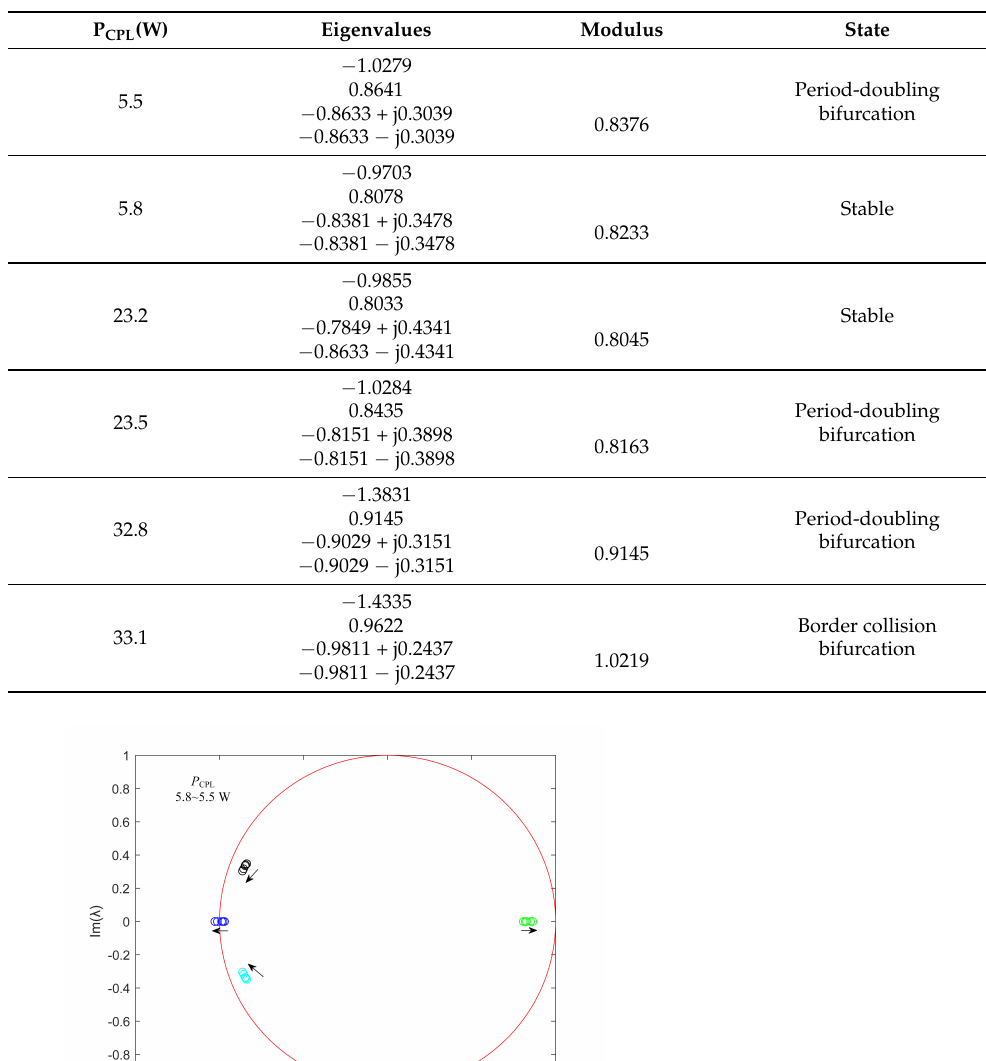
Table 2. Eigenvalues at typical load power.